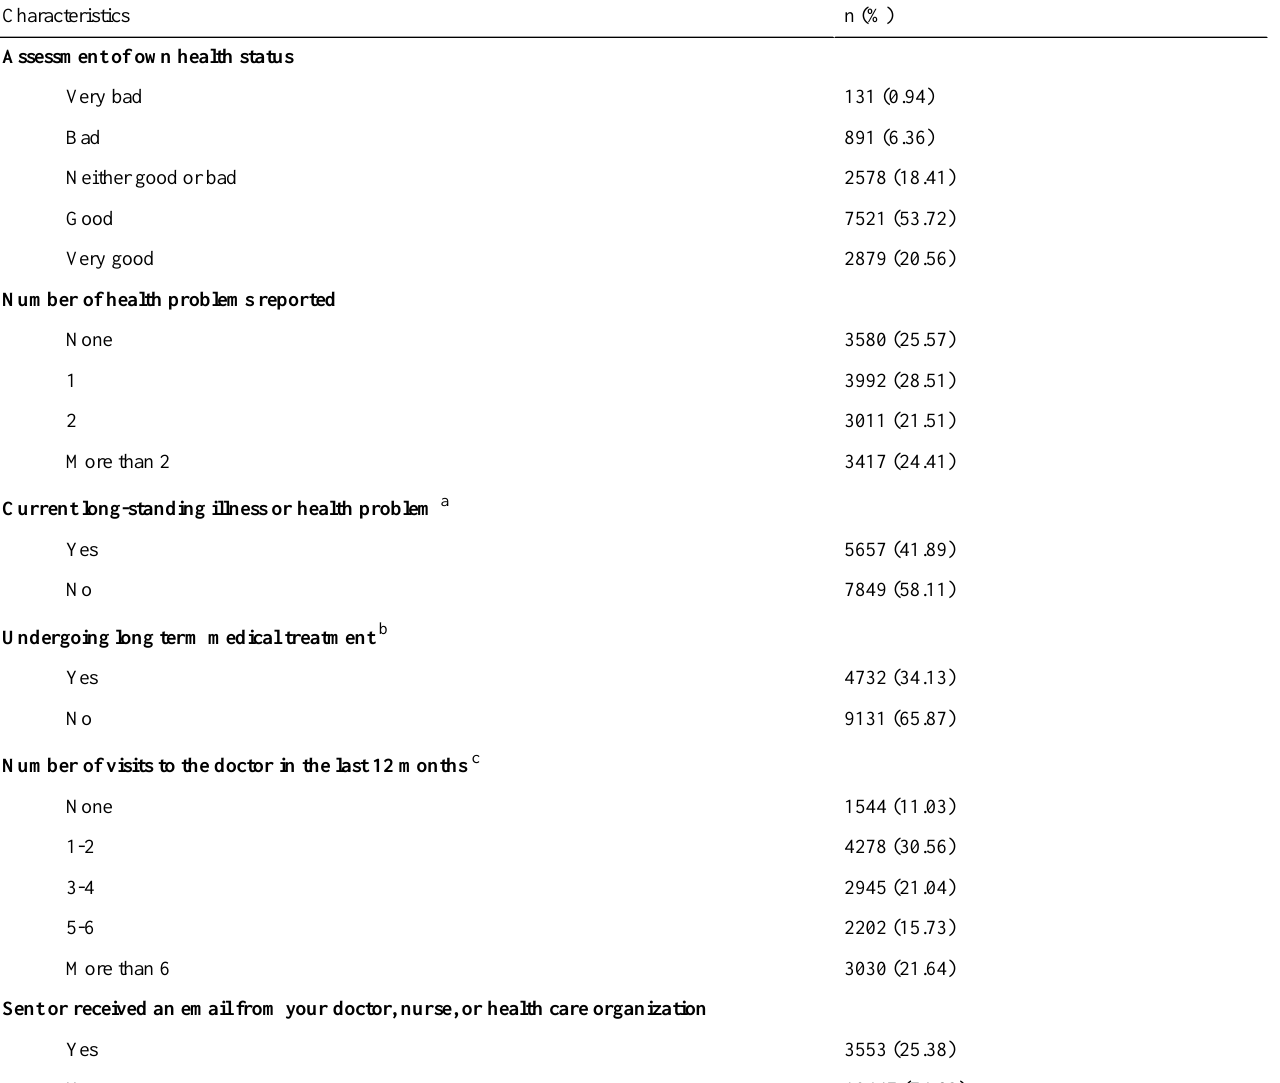
Table 3. Characteristics of